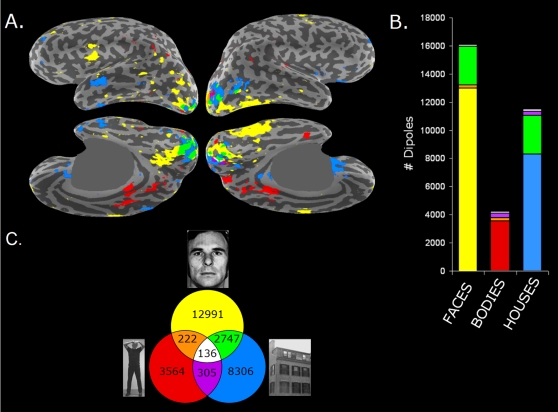
Category-specific cortical distribution of the M100 Inversion Effect.A. Overview of the cortical distribution of the Inversion Effect for the M100 component for the three different stimulus categories. The three t-maps of figure 4 were combined into a single map. Dipole positions at which the Inverted stimuli induced significantly (p<0.01) larger currents than their canonical Upright presentation within the 70–100-ms time-window are color-coded according to stimulus category and their spatial overlap as displayed in panel C. B. Bar graph displaying the number of dipoles showing a significant Inversion Effect for Faces, Bodies and Houses. Within each stimulus category the color (color coding as in C) indicates the degree of category-specificity, i.e. the amount of spatial (non-)overlap with the other categories. The amount of spatial overlap between categories is small (see also panel C for the exact number of dipoles). C. Color coding of stimulus category and their spatial overlap as used in panels A and B, with the exact number of dipoles showing a significant Inversion Effect.